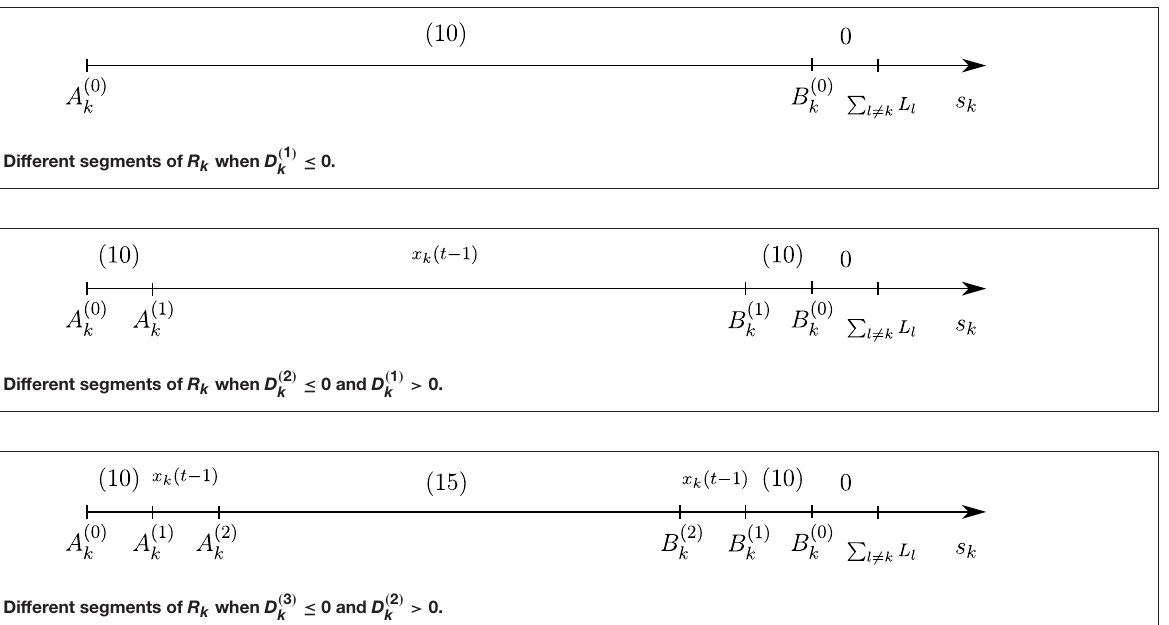
FIGURE 4 | Different segments of R k when D ( 3 ) k ≤ 0 and D ( 2 ) k > 0.